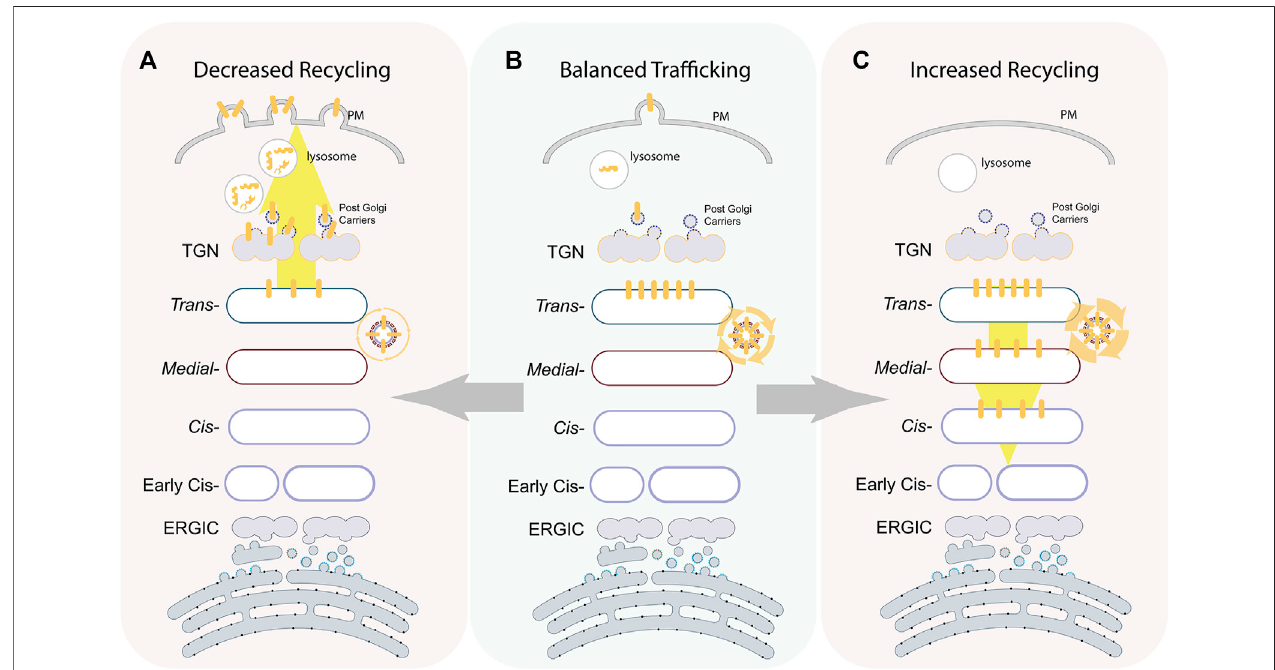
FIGURE3| Intra-Golgirecyclingcontrollingglycoenzymespositioningandlevels.Theillustrationdepictsthelocalizationofaprototypic trans- glycoenzymes(yellow bars) at different states. At a steady state maturation, machinery maintains the enzymes to localize to a speci fi c sub-Golgi compartment by continuous recycling (B) . Overexpression of components of the recycling machinery increase in intra-Golgi retrograde transport of the enzymes that redistribute the enzymes back in the whole Golgi (C) . On the other hand, depletion of components of the recycling machinery results in a loss of enzymes from the Golgi toward lysosomes or PM where they undergo degradation or ectodomain shedding, respectively (A)